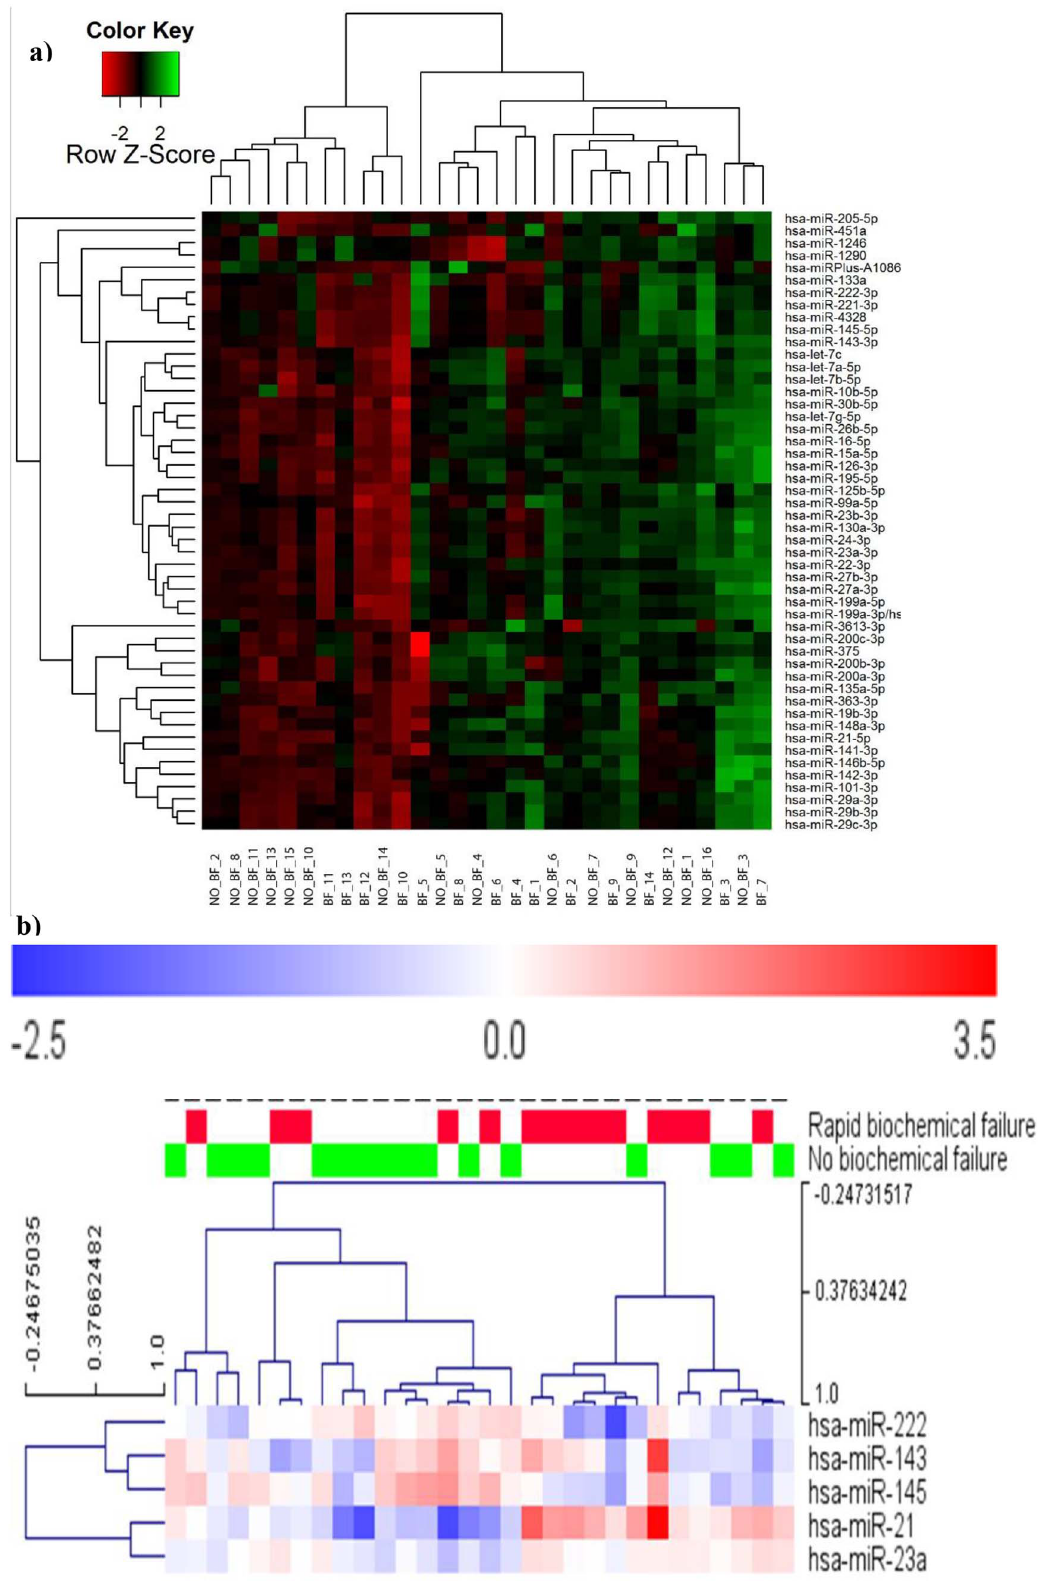
Figure 1. Linkage hierarchical unsupervised clustering of differentially expressed miRNAs. a) Relative expression levels of 50 miRNAs that were expressed in all 30 matched tissue samples with Gleason score 7. The X-axis shows individuals and the Y-axis shows miRNAs. Red squares encode for up-regulated miRNAs and green squares encode for down-regulated miRNAs. b) Heat Map results of the two-way hierarchical clustering